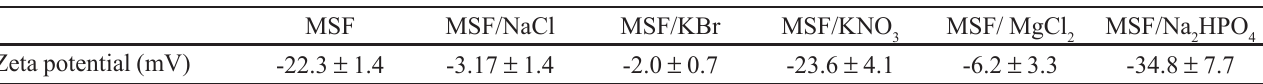
TABLE V - Effect of electrolyte addition ( I = 0.024 M) on zeta potential zeta of mate saponin fraction (MSF) solution at 10-fold its critical micelle concentration